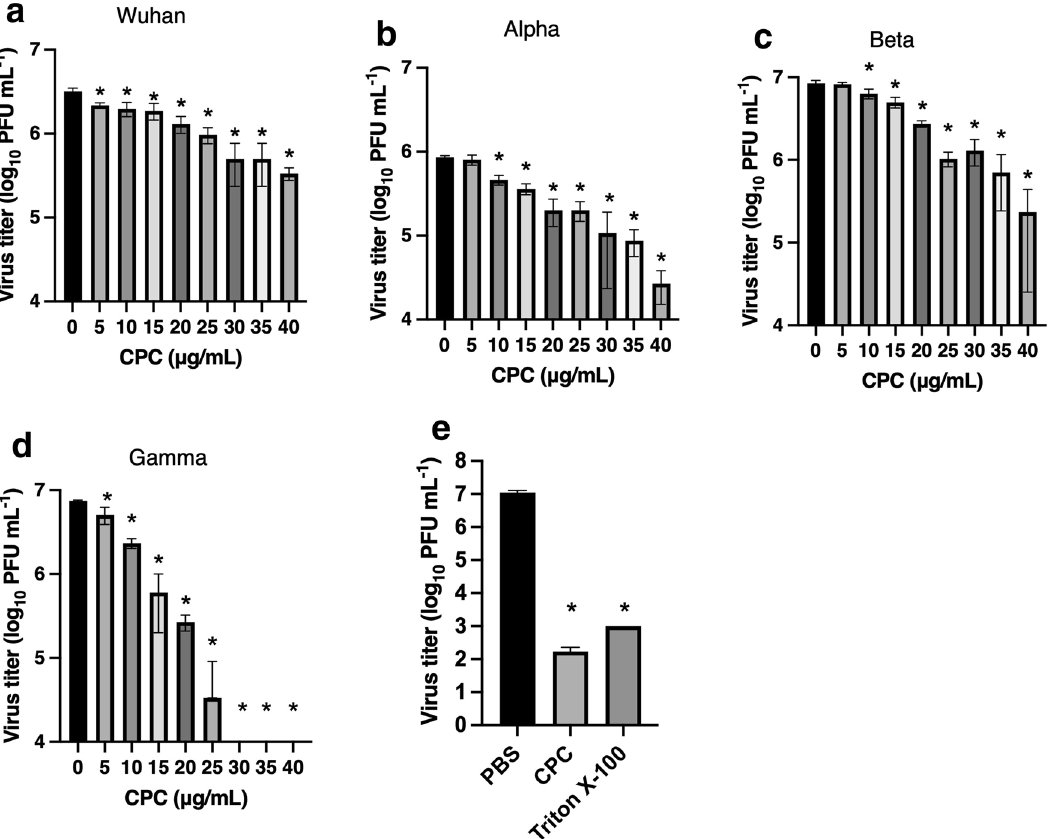
Figure 1. Antiviral efficacy of CPC against SARS-CoV-2 by plaque assay using Vero E6 cells expressing the TMPRSS2 gene (VeroE6/TMPRSS2). The virus titers were counted and the virus titer of SARS-CoV-2 Wuhan ( a ), Alpha ( b ), Beta ( c ) and Gamma ( d ) strains treated by CPC (0–40 μg/mL) at room temperature for 30 min were quantified and represented as PFU/mL. Plaque assay was also performed in the presence of PBS, CPC (50 μg/mL) or Triton X-100 (1%) for 10 min. Thereafter, samples were filtered by PD-10 columns to eliminate reagents ( e ). Statistical analysis was performed using one-way analysis of variance. (* p <